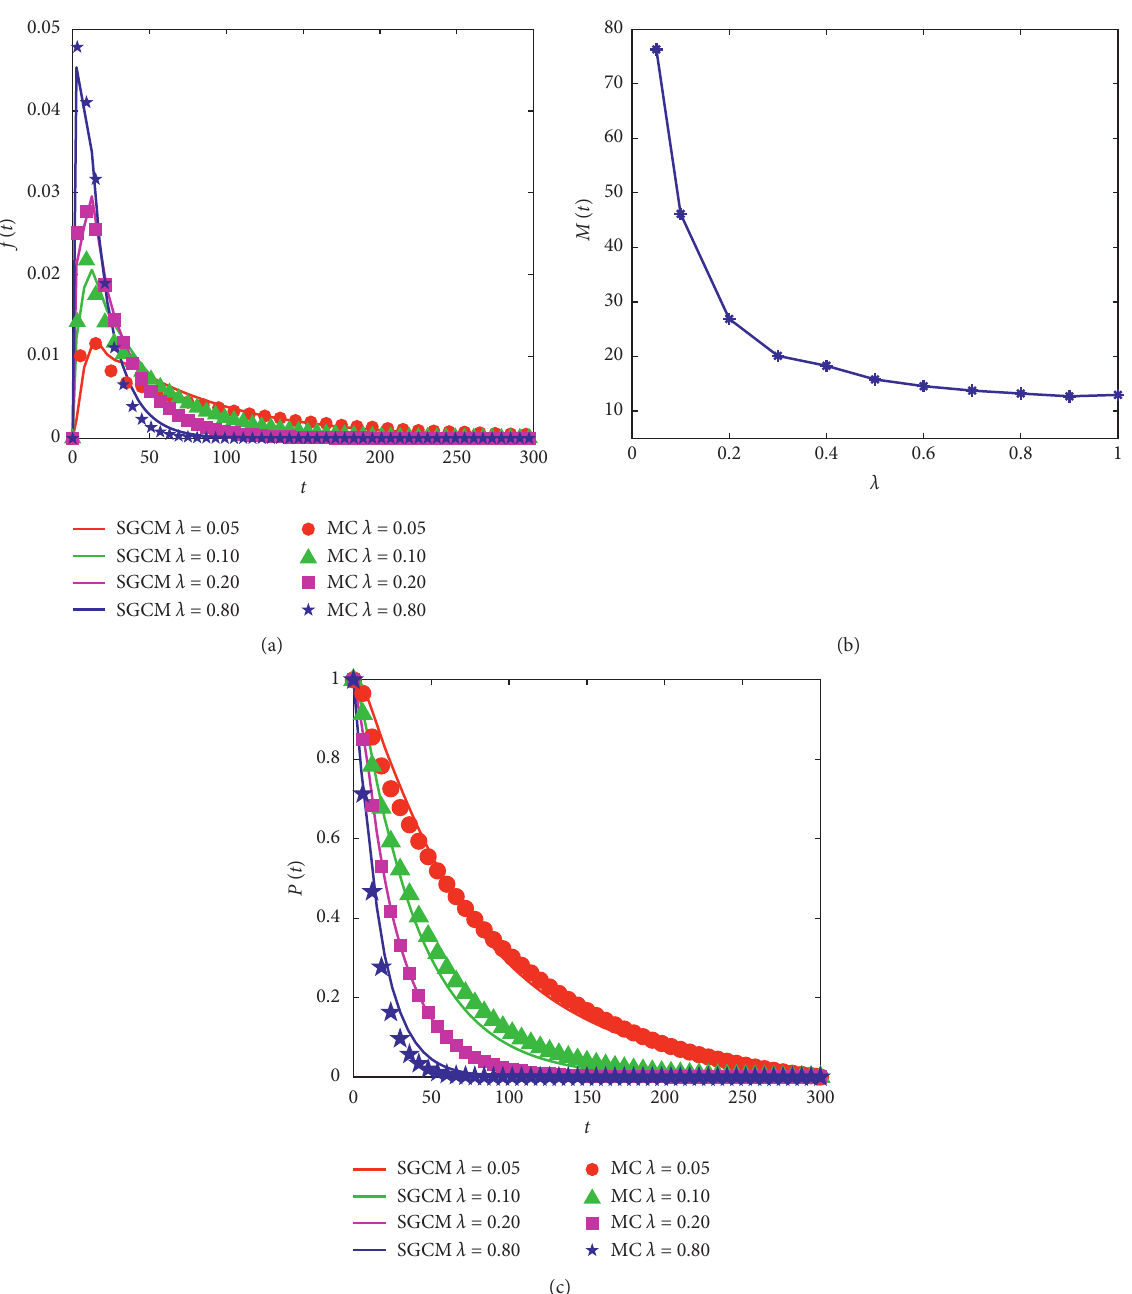
Figure 3: (a) Probability density function of FPT of system (6): D � 0 . 20. (b) MFPT of system (6): D � 0 . 20. (c) Reliability function of system (6): D � 0 .